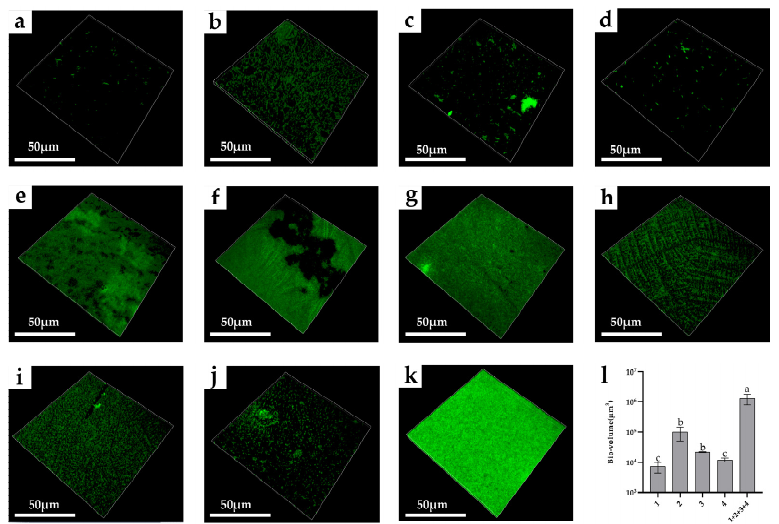
Figure 8. CLSM images of mono- and mixed-species biofilms. ( a ) B. longum ; ( b ) E. faecalis ; ( c ) B. ovatus ; ( d ) L. gasseri ; ( e ) B. longum + E. faecalis ; ( f ) B. longum + B. ovatus ; ( g ) B. longum + L. gasseri ; ( h ) E. faecalis + B. ovatus ; ( i ) E. faecalis + L. gasseri ; ( j ) B. ovatus + L. gasseri ; ( k ) B. longum + E. faecalis + B. ovatus + L. gasseri ; ( l ) Bio-volume of mono- and mixed-species biofilms. 1— B. longum , 2— E. faecalis , 3— B. ovatus and 4— L. gasseri . Lowercase letters above the bars represent statistically significant differences between these groups ( p < 0.05) after one-way